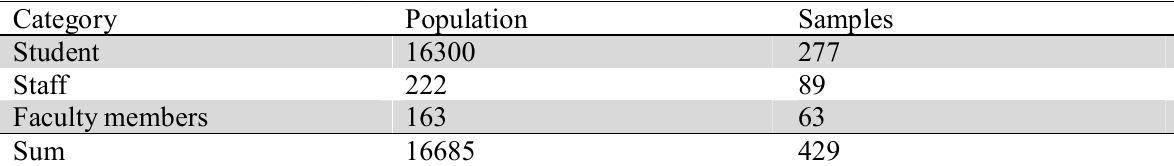
Personal characteristics of the participants